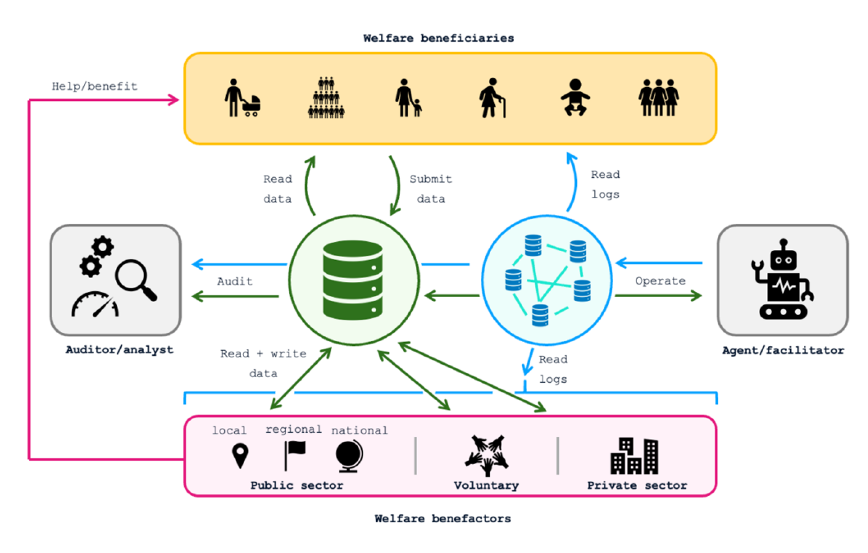
Figure 4: A Bitcoin-based Welfare Management